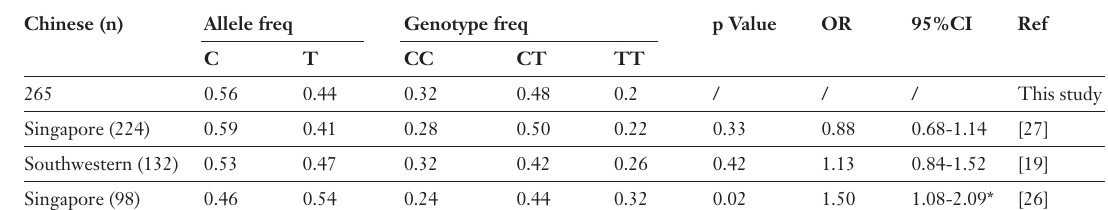
Table 3 The C allelic differ- ences of Chinese populations between the data in this study and those of other studies (allele C and T; genotype CC, CT and